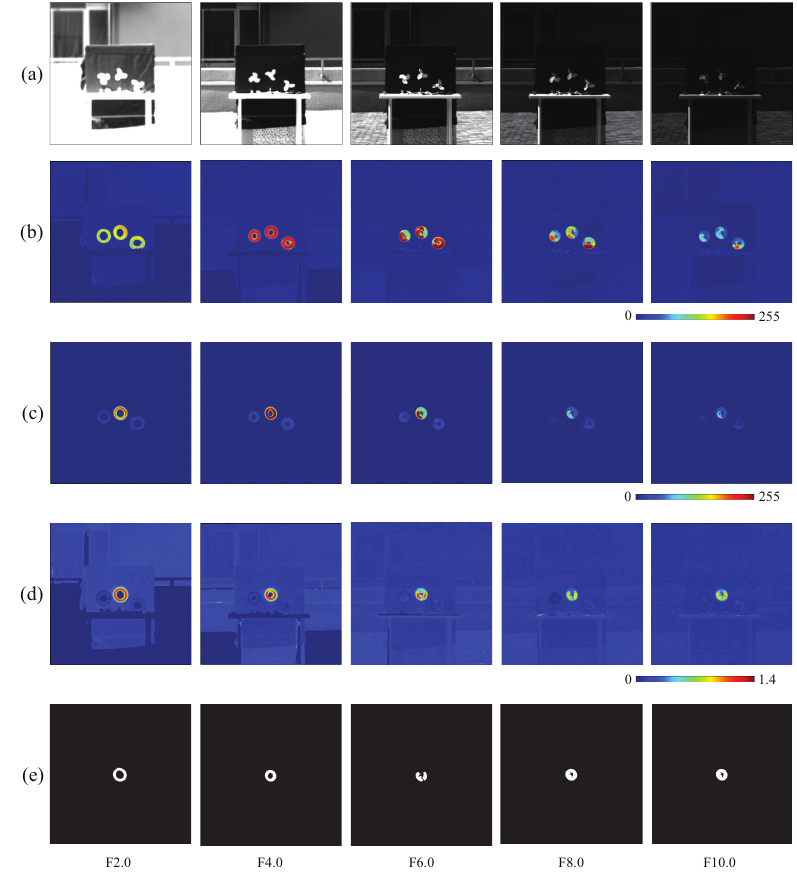
Figure 4. ( a ) Input images; amplitude of ( b ) input; and ( c ) pixel-wise filtered images; ( d ) amplitude ratios; ( e ) extra-cted vibration